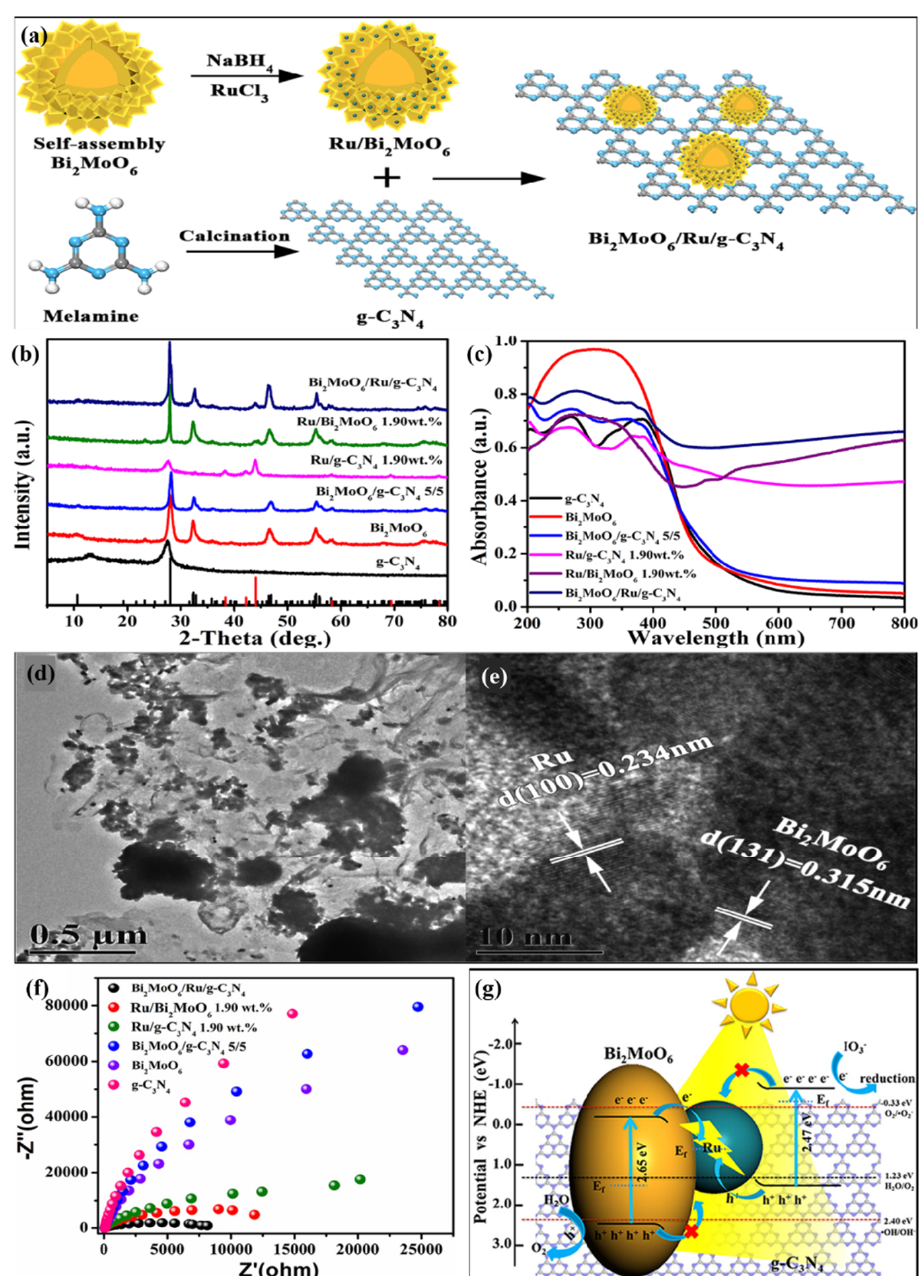
Figure 9. ( a ) Formation mechanism of the BO/Ru/CN ternary heterostructured material, ( b ) XRD patterns, ( c ) optical absorption spectra, ( d ) TEM image, ( e ) HRTEM image of BO/Ru/CN heterostructured material, ( f ) Nyquist plots, and ( g ) charge transfer mechanism of the BO/Ru/CN ternary heterostructured electrode. Reprinted with permission from reference [102], Copyright 2019, American Chemical Society. Table 2. The PEC performance of g-C 3 N 4 -based ternary heterostructured photoelectrodes.